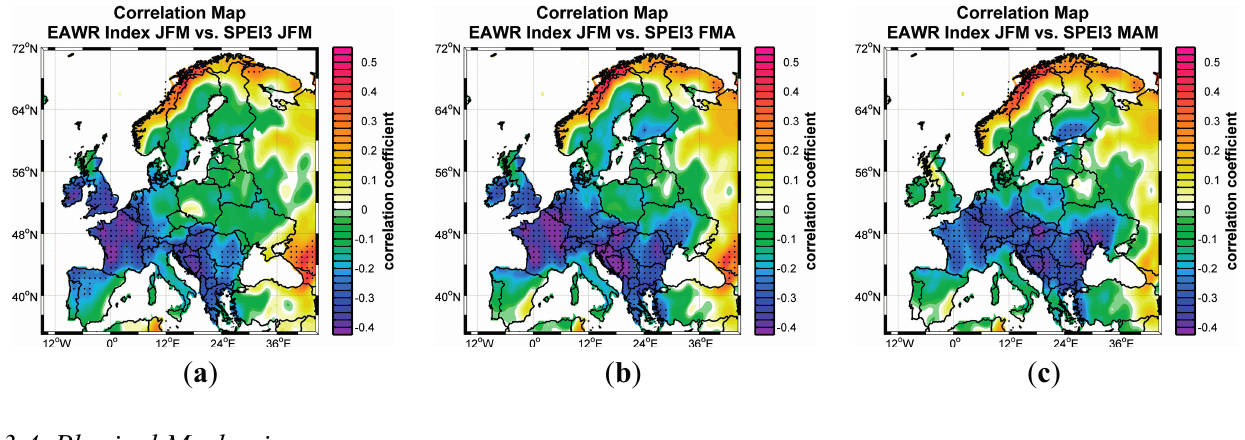
Figure 5. Correlation between the JFM EAWR and SPEI3 for ( a ) January to March (JFM); ( b ) February to April (FMA) and ( c ) March to May (MAM). Hatching displays areas at or over 95% significance level using a two tailed t-test